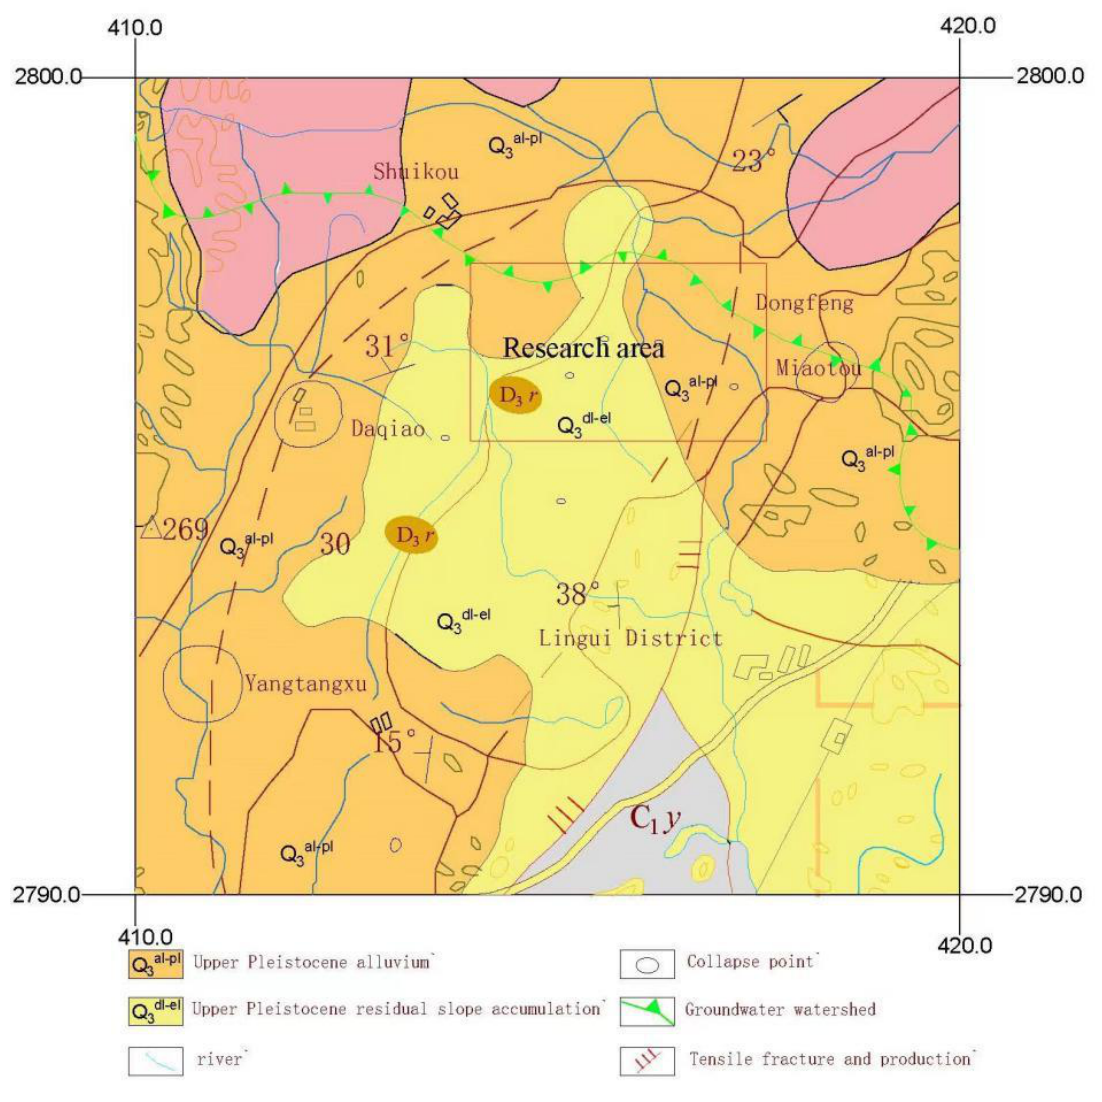
Figure 1. Engineering geological map.